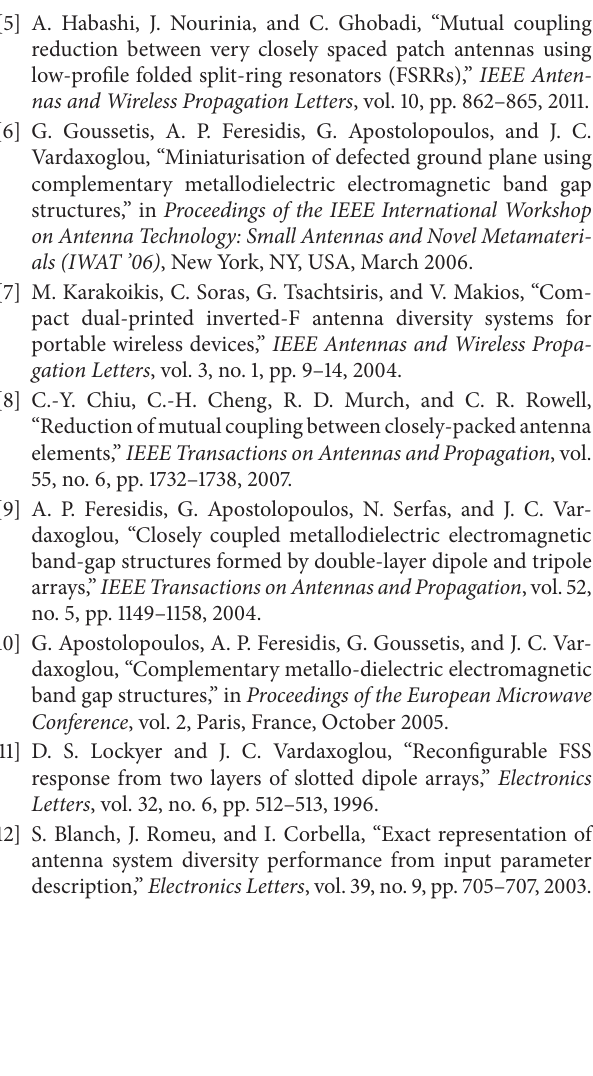
Figure 11: Total efficiency of PIFAs without and with two slits or four